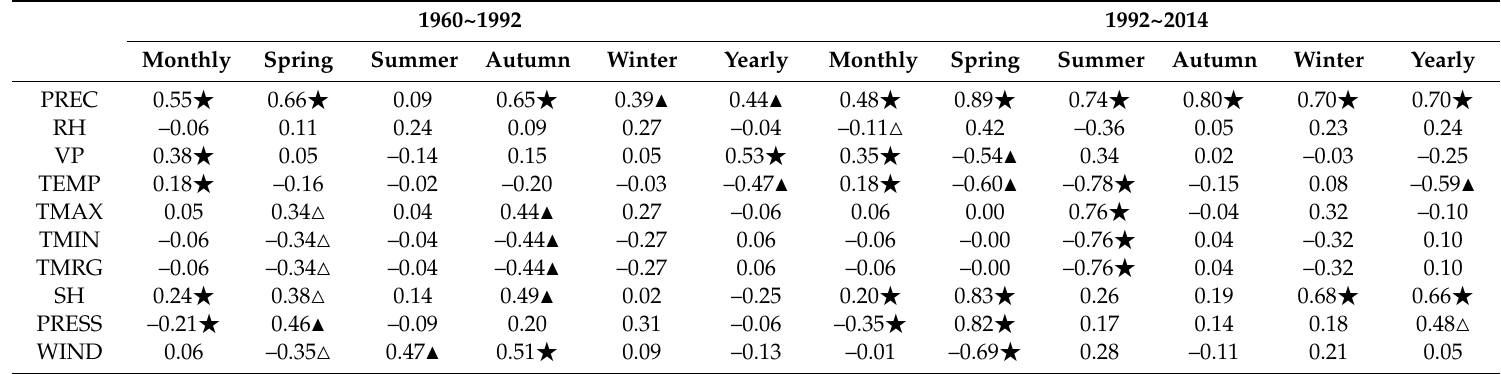
Table 4. Partial correlation coe ffi cients between climatic factors and the ETa during the two periods of time in the Pearl River